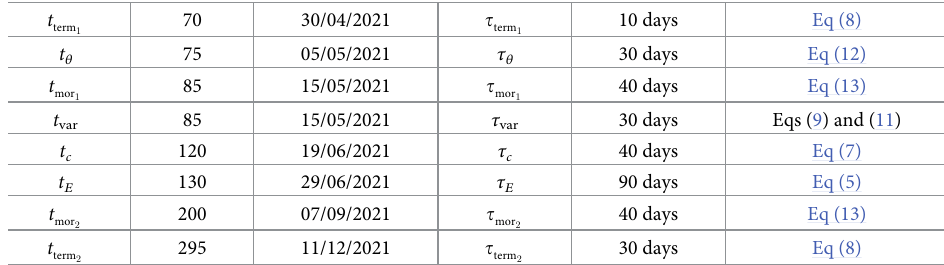
Table 4. Time intervals and reference days in Eqs (7)–(13),obtained as fitting